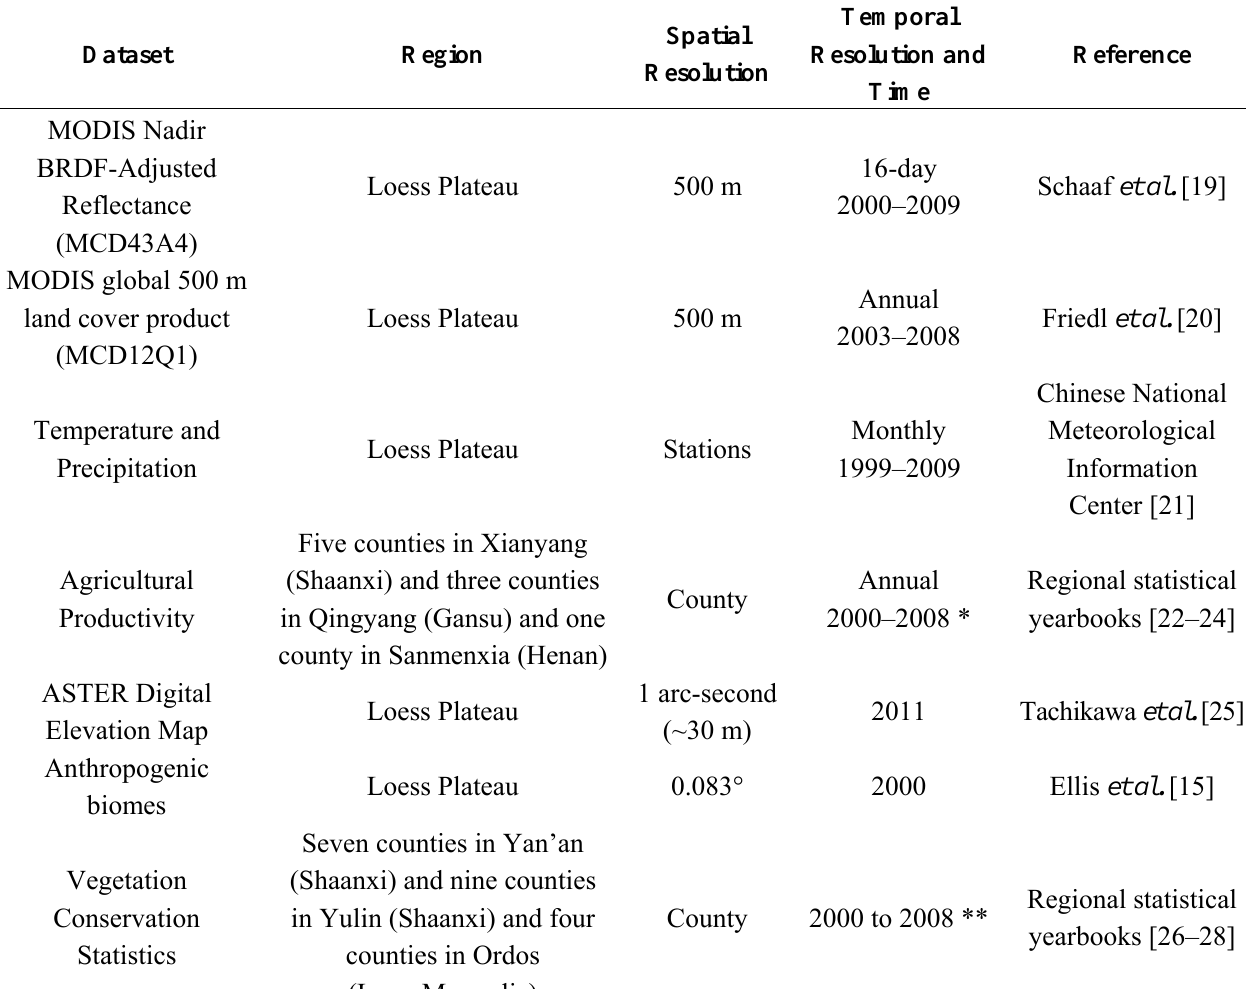
Table 1. Overview of data